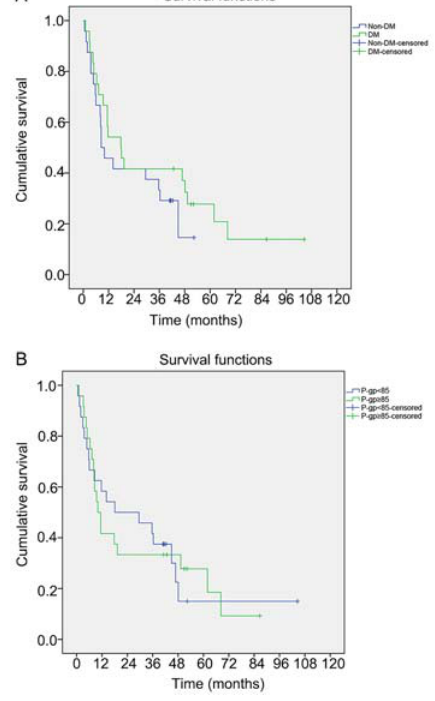
Figure 4. Kaplan-Meier analysis of survival time in patients with pancreatic cancer with or without diabetes mellitus (DM) (P=0.284) ( A ) and duodenal P-glycoprotein (P-gp) score o or X 85 (P=0.981) ( B